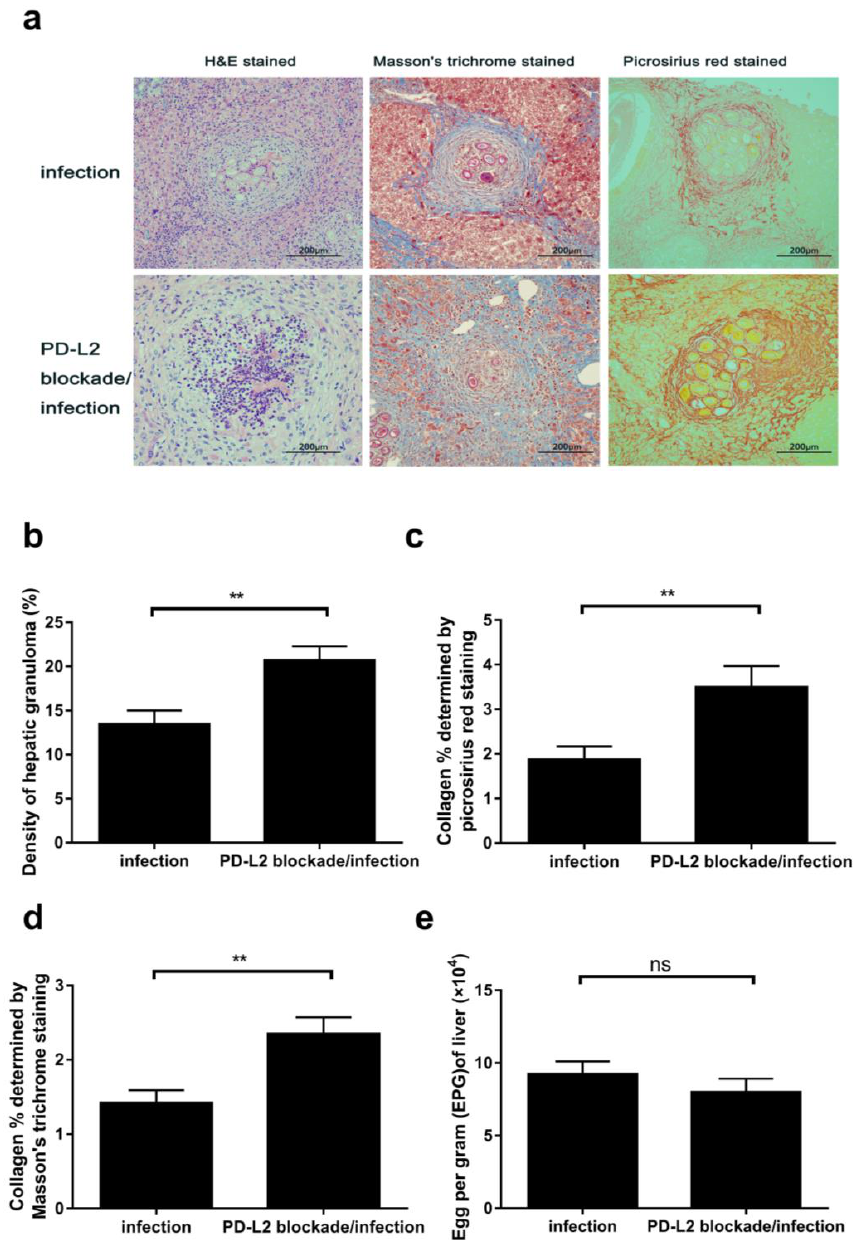
Figure 3. PD-L2 blockade deteriorated hepatic pathology of mice infected with C. hepatica: ( a ) Representative histopathological sections of livers of mice infected with C. hepatica treated with anti-mouse PD-L2 monoclonal antibody or isotype control. Liver sections were stained with H&E, Masson’s trichrome, or Sirius Red to reveal the inflammatory cell infiltration and collagen deposition within the egg granulomas. Images are representative of three independent experiments and observed by microscopy at 200× magnification. ( b ) The density of hepatic granulomas measured by stereological point-counting (SPC) in the sections of mice treated with anti-PD-L2 or not [20]. ( c ) The average area of collagen stained with Sirius Red in livers of experimental mice from four view fields, performed by the ImageJ software (version 1.48). ( d ) The average area of collagen stained with Masson’s trichrome stain in liver tissue from four view fields, performed by the ImageJ software. ( e ) Eggs per gram (EPG) in livers of mice treated with anti-PD-L2 antibody or isotype control. Data are expressed as mean ± SEM from three independent experiments ( n = 5 mice per group). ** p < 0.01 between two groups. ns, not